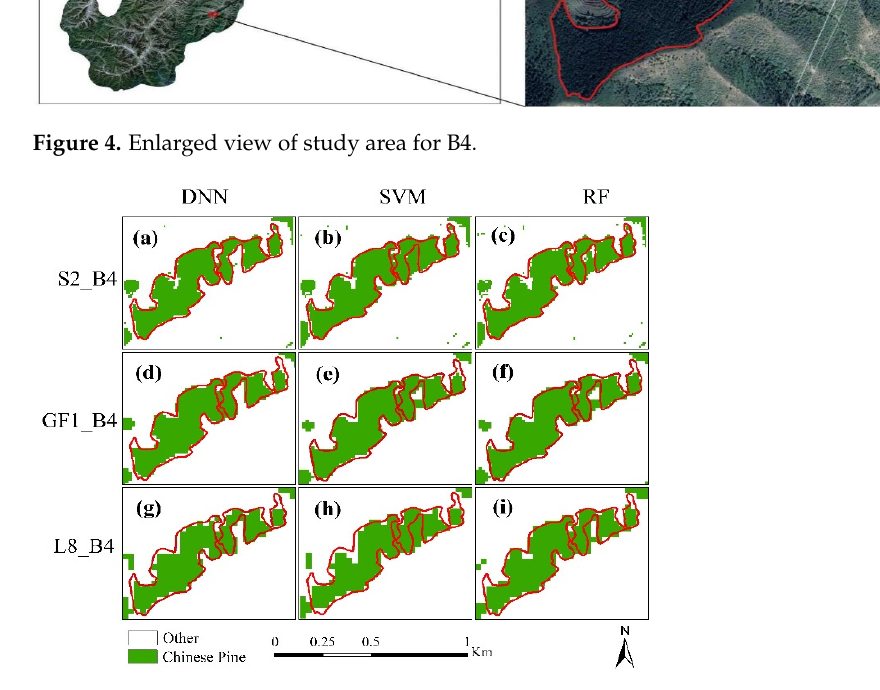
Figure 5. Extraction results of Chinese pine using B4 dataset, ( a – c ) The extrction results using Sentinel-2; ( d – f ) The extrction results using Gaofen-1; ( g – i ) The extrction results using Landsat-8 OLI.